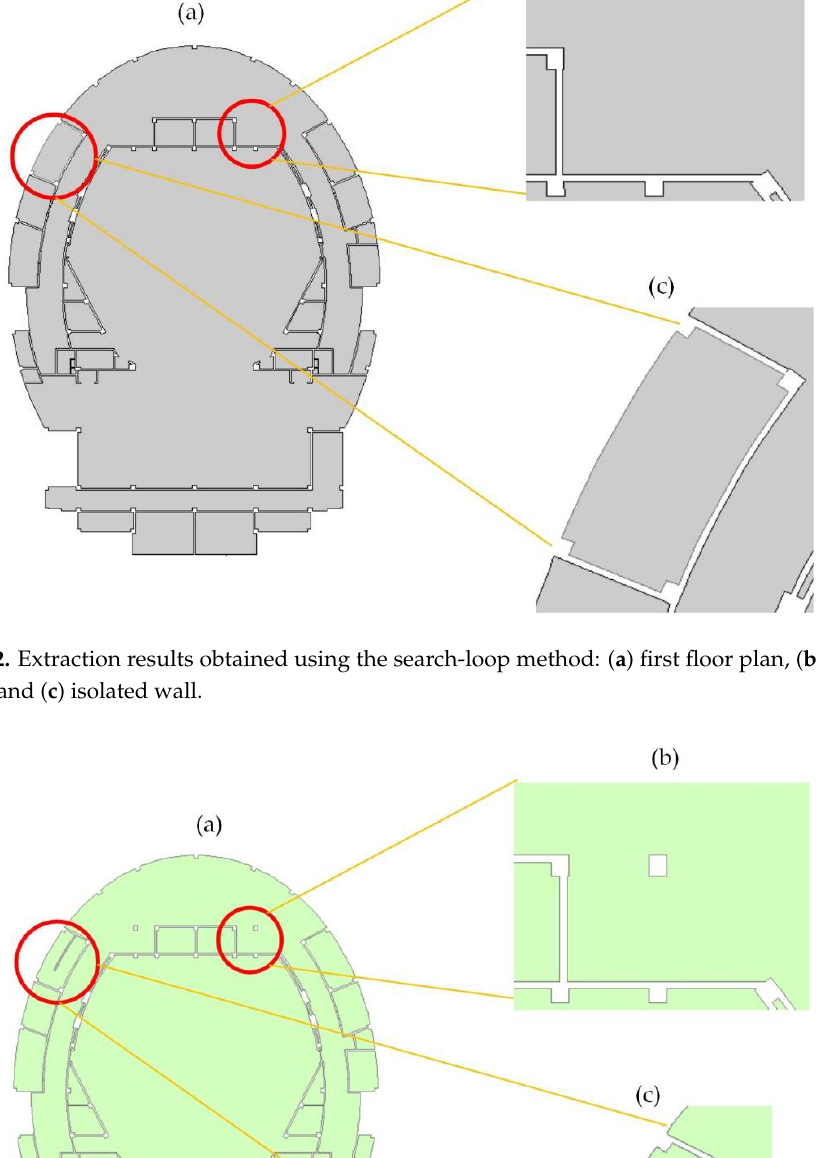
Figure 21. Situation of isolated components: ( a ) first floor plan, ( b ) isolated column, and ( c ) isolated wall.